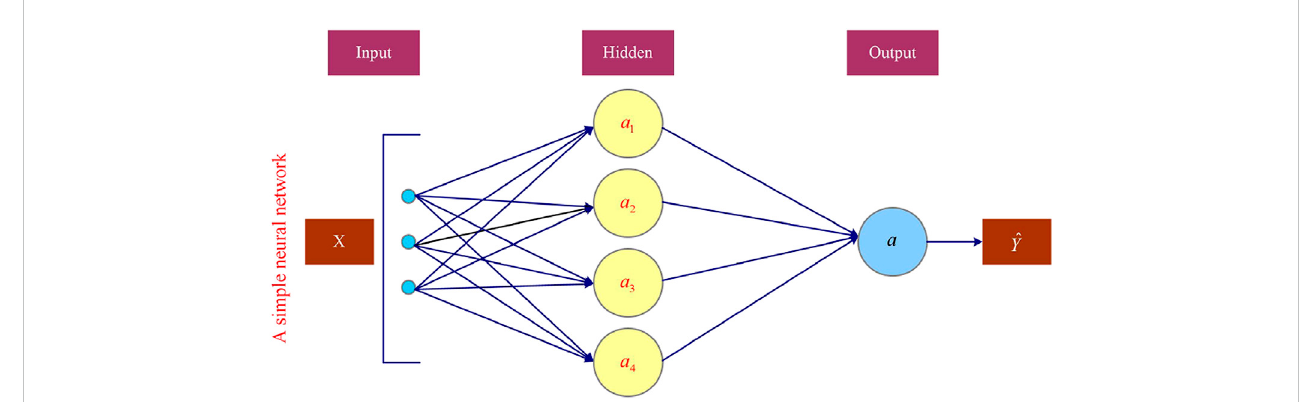
FIGURE 1 The simplest MLP model structure.